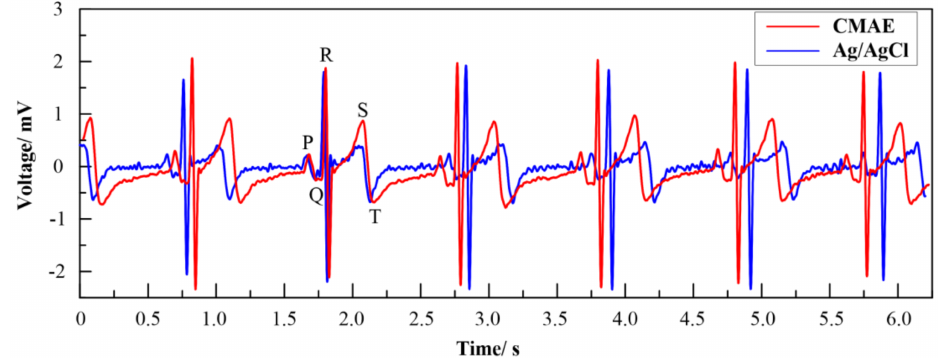
Figure 10. ECG signals recorded by the CMAE and Ag/AgCl